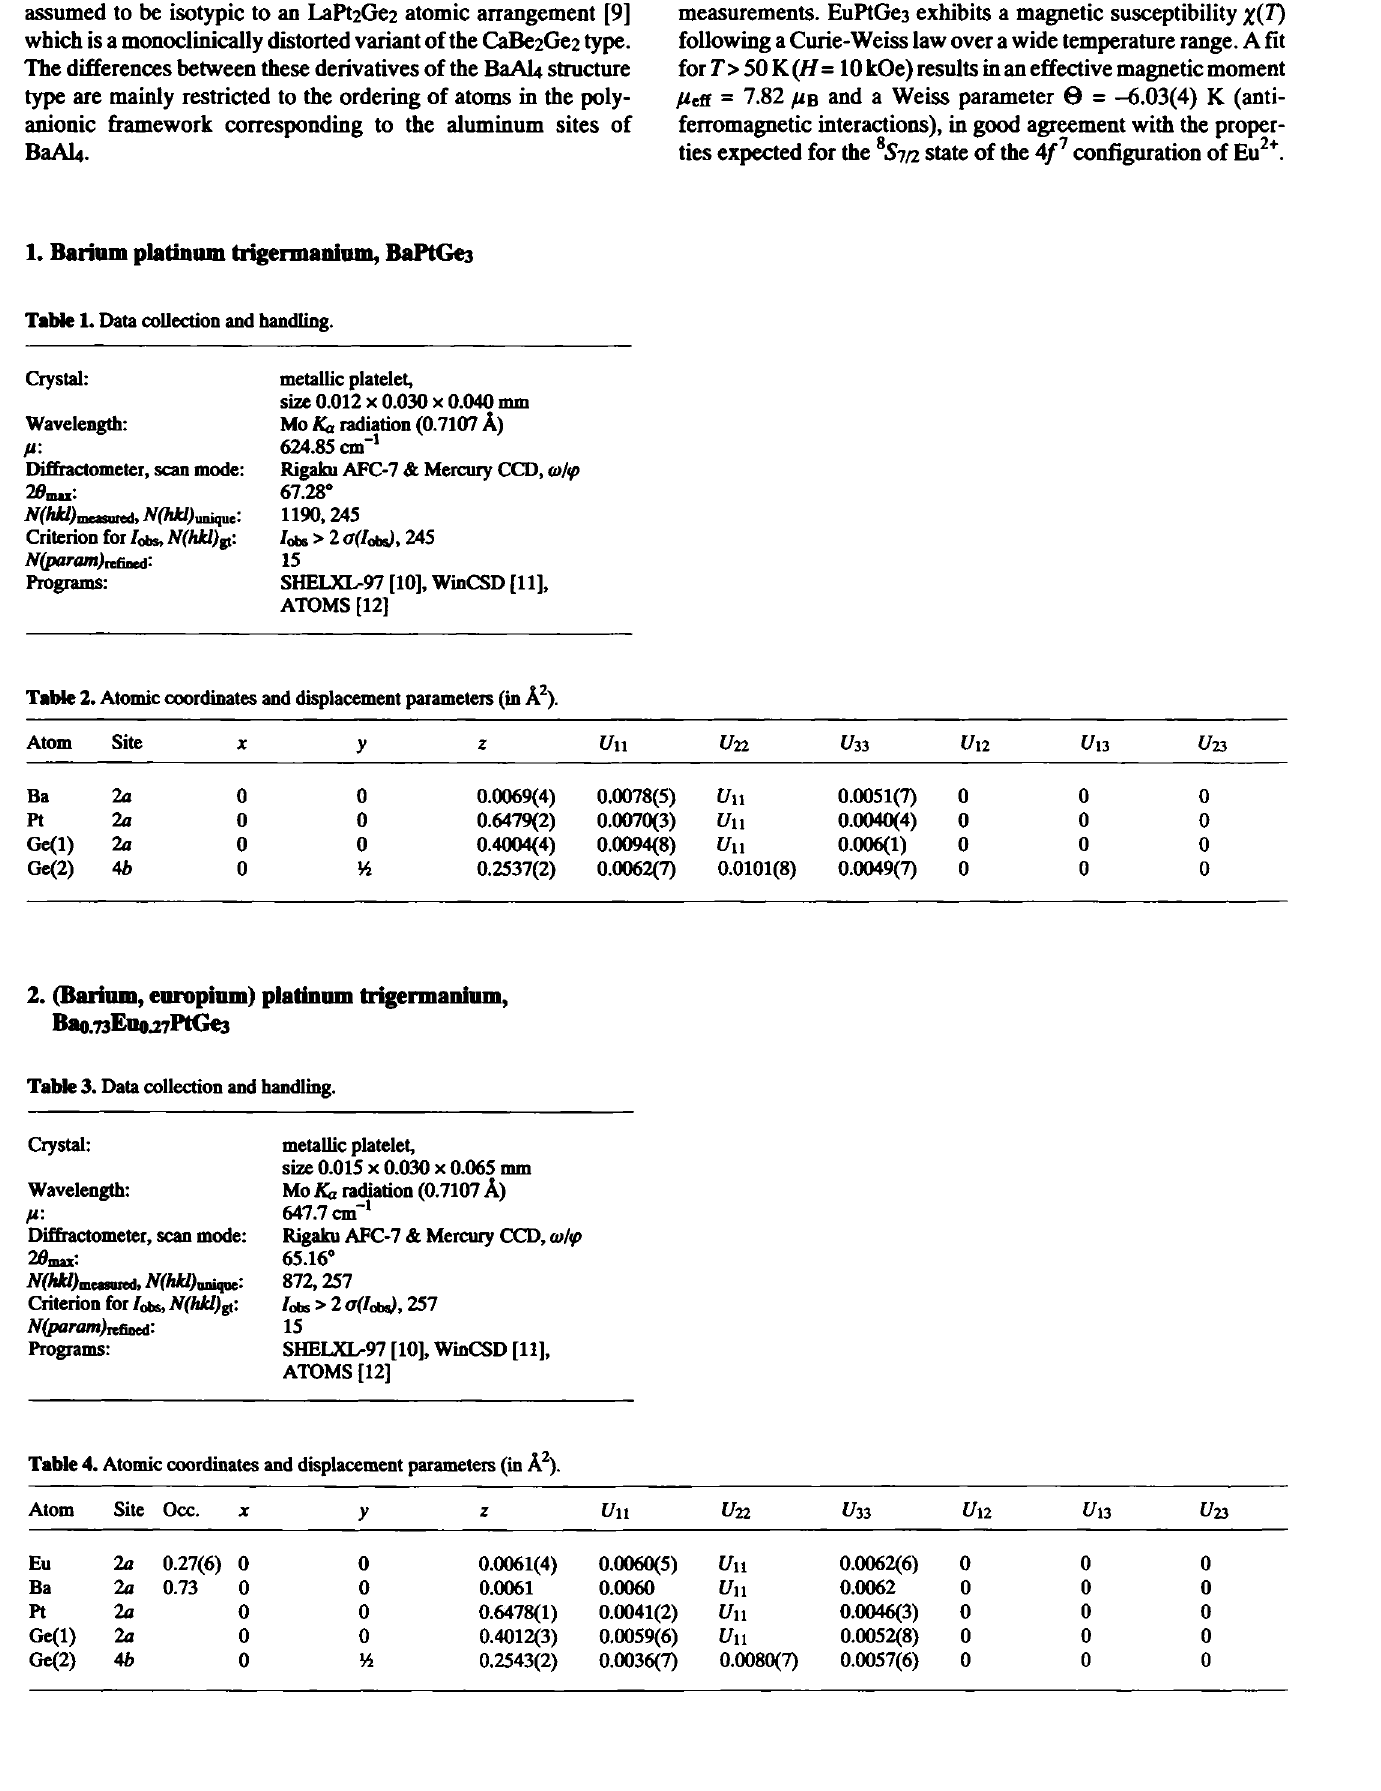
Table 1. Data collection and handling.